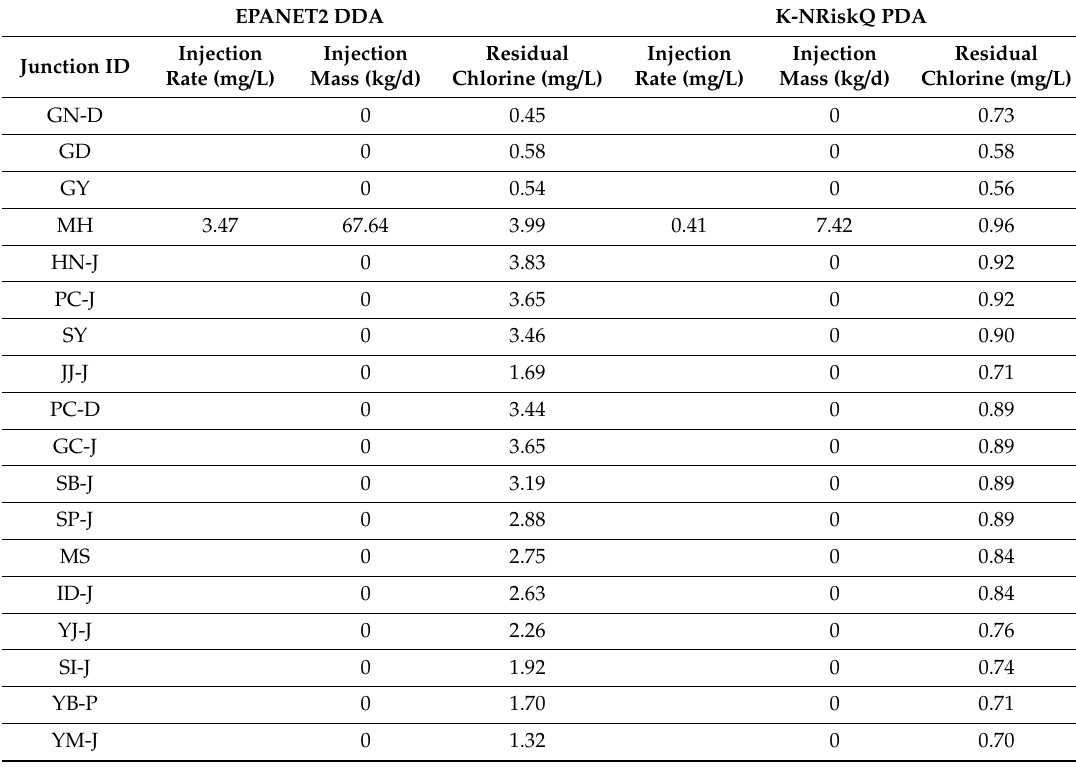
Table 6. Two injection-point results under normal conditions.